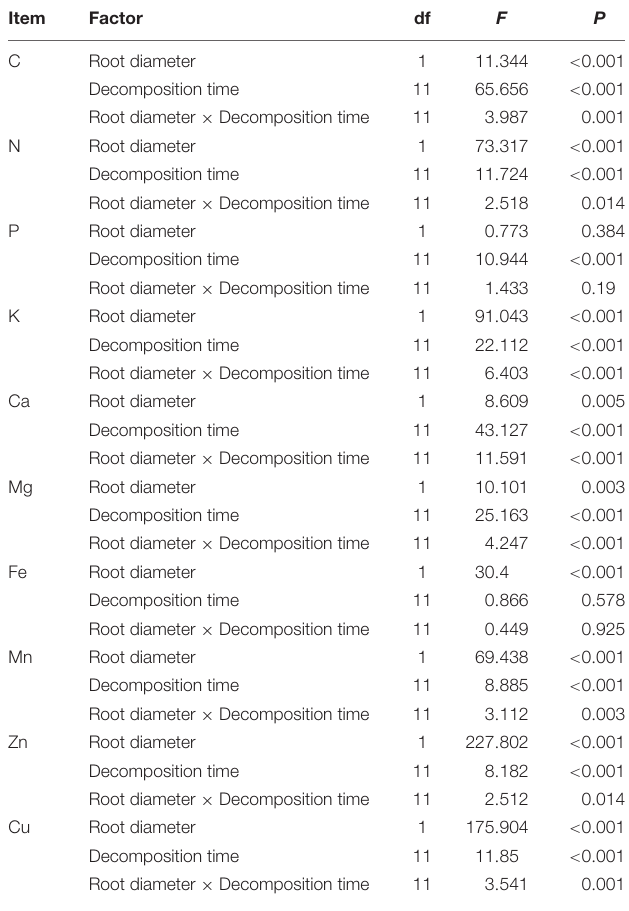
TABLE 4 | Two-way ANOVA for decomposition time and root diameter effects on element remaining